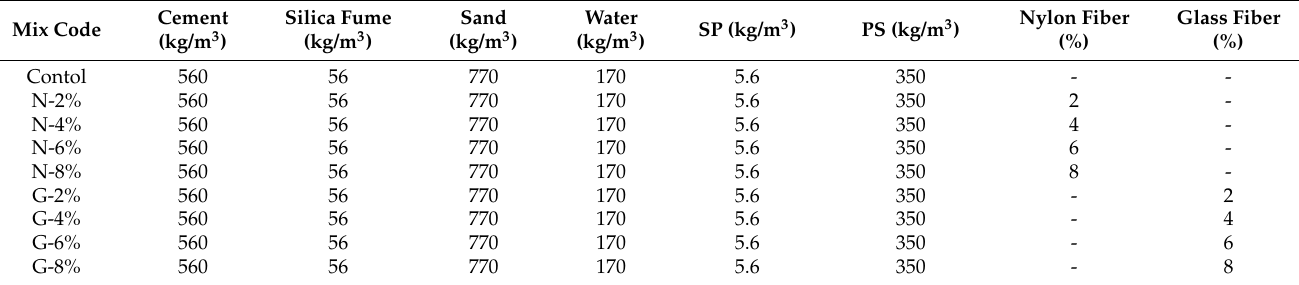
Table 4. Mix proportion of